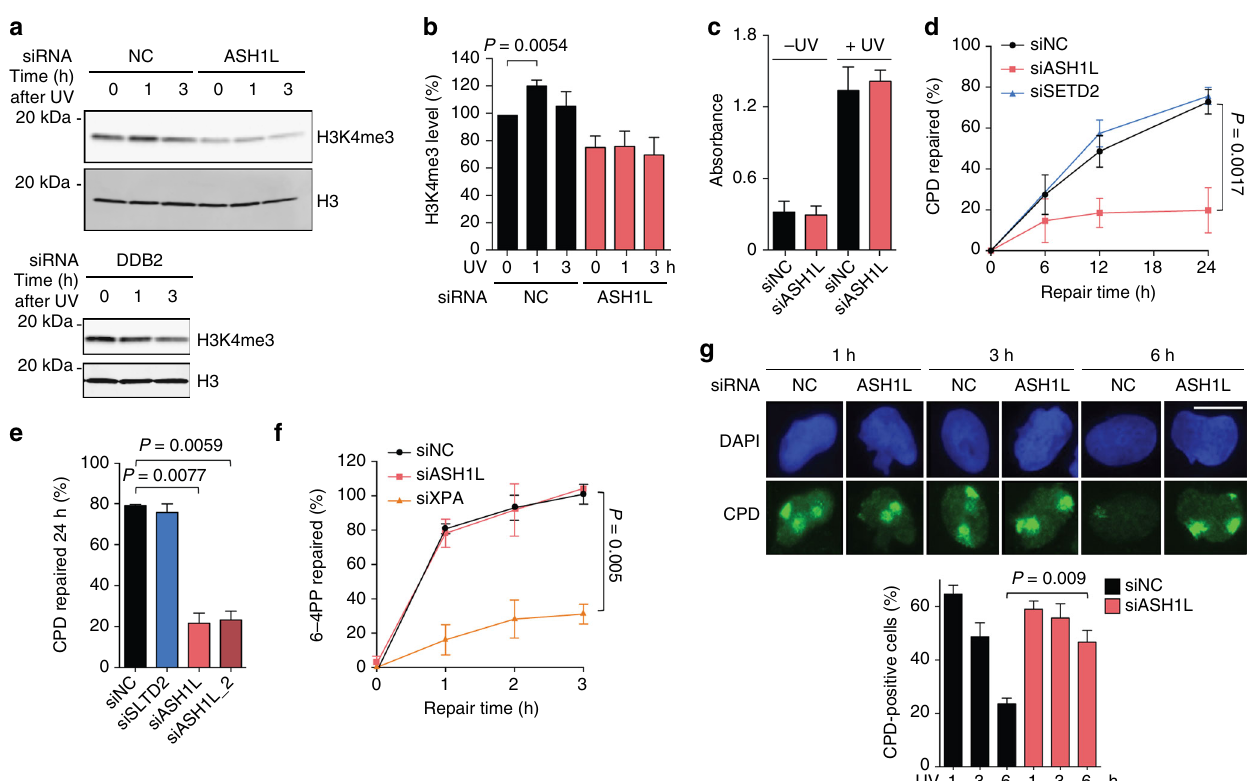
Fig. 2 Impaired CPD excision upon ASH1L depletion. a Visualization of H3K4me3 in ASH1L-depleted HeLa cells. Whole cell lysates were analyzed by immunoblotting using antibodies against the indicated forms of H3. UV radiation was at 10 J m – 2 . b Quanti fi cation of H3K4me3 levels normalized to total H3 ( n = 6 independent experiments). Error bars show s.e.m. (one-sample t-test). c Initial CPD formation after UV irradiation. HeLa cells were transfected with siASH1L or siNC, UV-irradiated (10 J m – 2 ) 48 h later and immediately collected for CPD analysis. Immunoassay absorbance, providing a measure of CPDs, were not affected by the ASH1L depletion (n = 3, each experiment with 4 replicates; two-tailed t-test). d Excision of CPDs in HeLa cells treated 48 h before UV radiation (10 J m – 2 ) with siRNA targeting ASH1L or SETD2, compared to transfections with siNC ( n = 5, each experiment with 4 replicates, two- tailed t-test). e Excision of CPDs in HeLa cells transfected 48 h before UV radiation (10 J m – 2 ) with siASH1L, siASH1L_2 or siSETD2, compared to siNC. CPDs were measured immediately after UV treatment and after a 24-h repair period ( n = 3 with 4 replicates each, two-tailed t-test). f Excision of 6 – 4PPs in HeLa cells transfected 48 before UV radiation (10 J m – 2 ) with siRNA targeting ASH1L in comparison to siXPA and siNC ( n = 3 with 4 replicates each, two- tailed t-test). g Immuno fl uorescence detection of CPDs in cells transfected with siASH1L or siNC, 48 h before UV radiation (100 J m – 2 ) through 5- µ m fi lter pores. DNA was stained with DAPI. The quanti fi cation of nuclei positive for CPD spots is based on a minimum of 100 cells ( n = 3 independent experiments, two-tailed t-test). Scale bar = 15 µ m. Representative wide- fi eld views of cells are shown in Supplementary Fig.